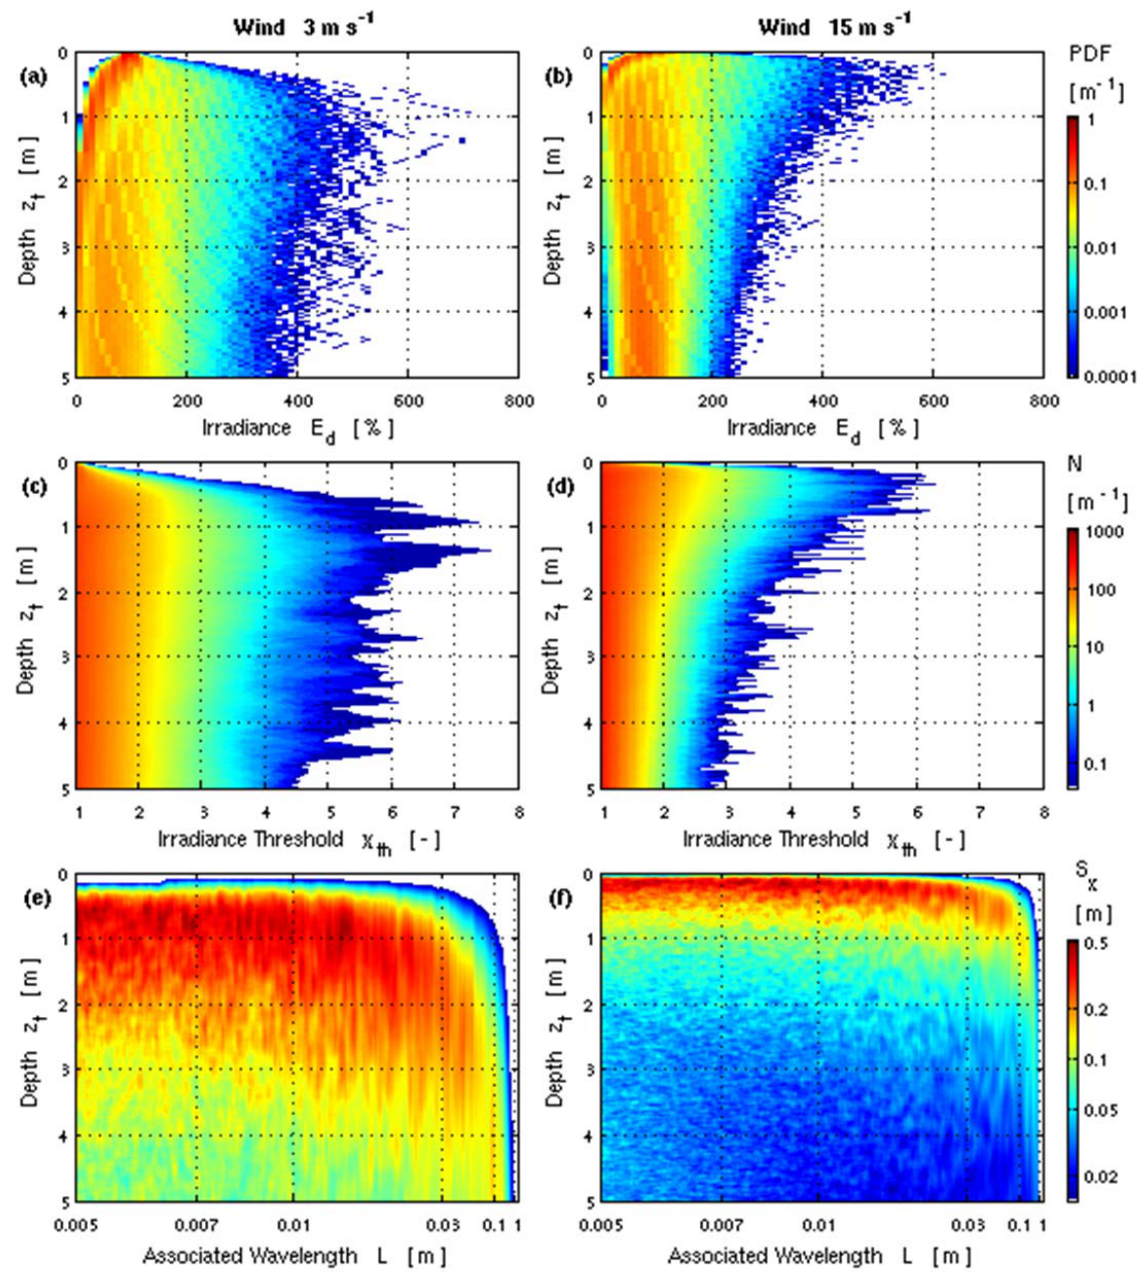
Fig. 5. Statistics of the underwater light fields from Fig. 4 with wind velocities of 3ms − 1 (left) and 15ms − 1 (right); top: probability density Fig. 5 : Statistics of the underwater light fields from Fig. 4 with wind velocities of 3 function PDF of downwelling irradiance E d ; middle row: number of flashes N above a certain irradiance threshold χ th ; lower panels: power spectral density S χ with respect to the normalized irradiance. 3 m s ‐ 1 (left) and 15 m s ‐ 1 (right); top: probability density function PDF of downwelling 4 irradiance E ; middle row: number of flashes N above a certain irradiance threshold χ d at moderate wind speeds, whereas the flash intensity is evi- small amplitudes of the power spectral density S χ . We see lower panels: power spectral density S with respect to the normalized irradiance. 6 χ dently reduced at the same depth at strong wind. stronger and distinctly deeper reaching variance at 3 m s − 1 wind speed. In both cases irradiance fluctuations near the sur- Fig. 5e and f. Red colours stand for spectral ranges that con- face are governed by small waves of less than 5 cm length tribute large amounts to the variability of the normalized ir- (the bounds of the wavelength range with most wind friction radiance χ . White and bluish colours denote negligible and dependency (0.007 and 0.03 m) are additionally